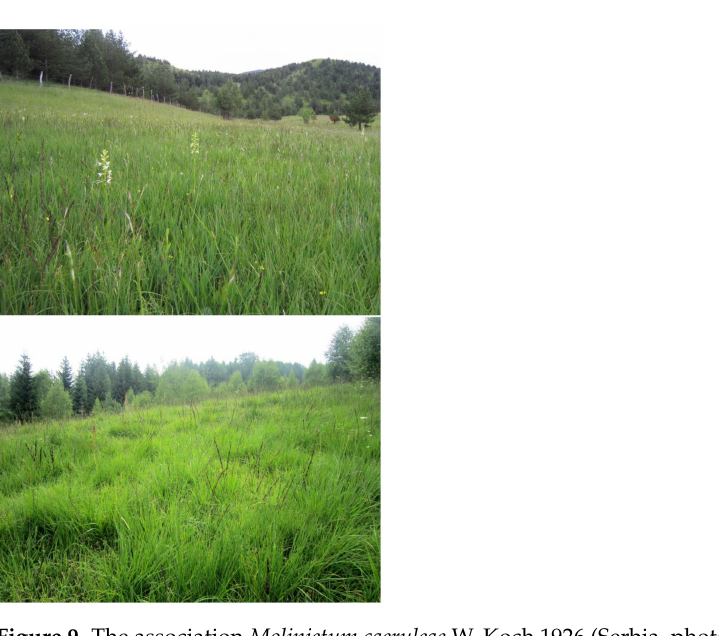
Figure 9. The association Molinietum caeruleae W. Koch 1926 (Serbia, photos V.